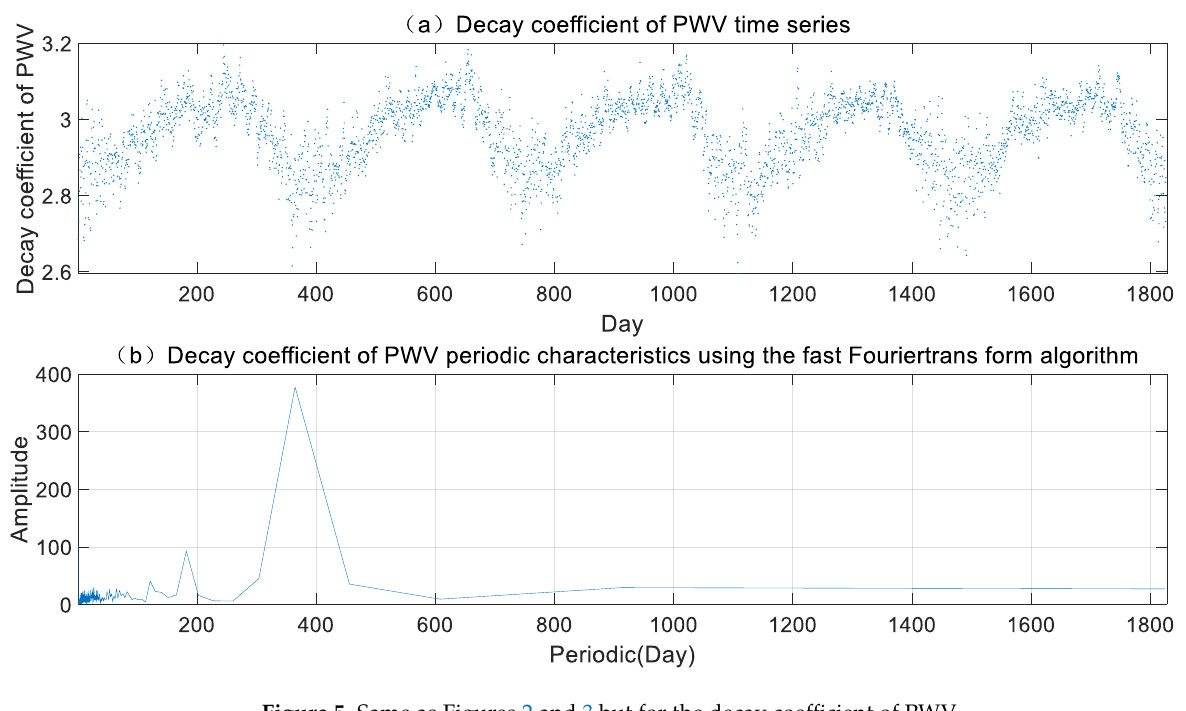
Figure 5. Same as Figures 2 and 3 but for the decay coefficient of PWV.